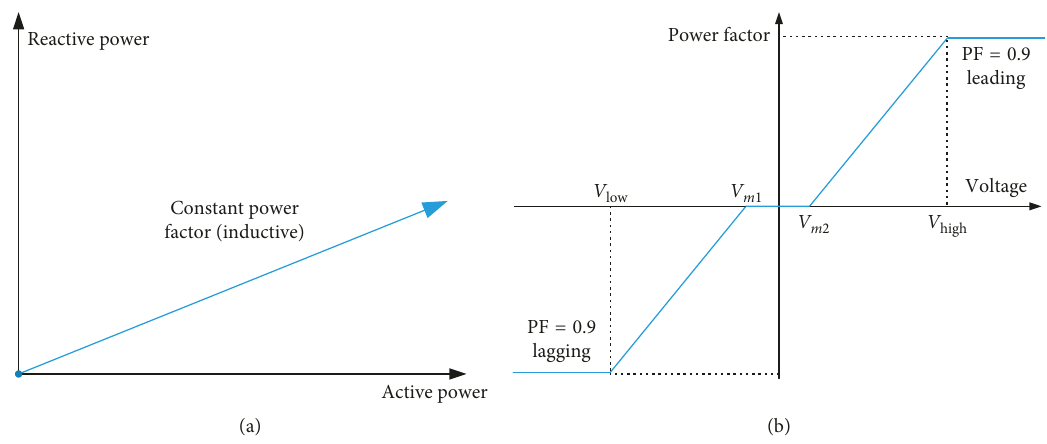
Figure 3: Traditional Var compensation methods: (a) constant power factor curve; (b) power factor droop curve